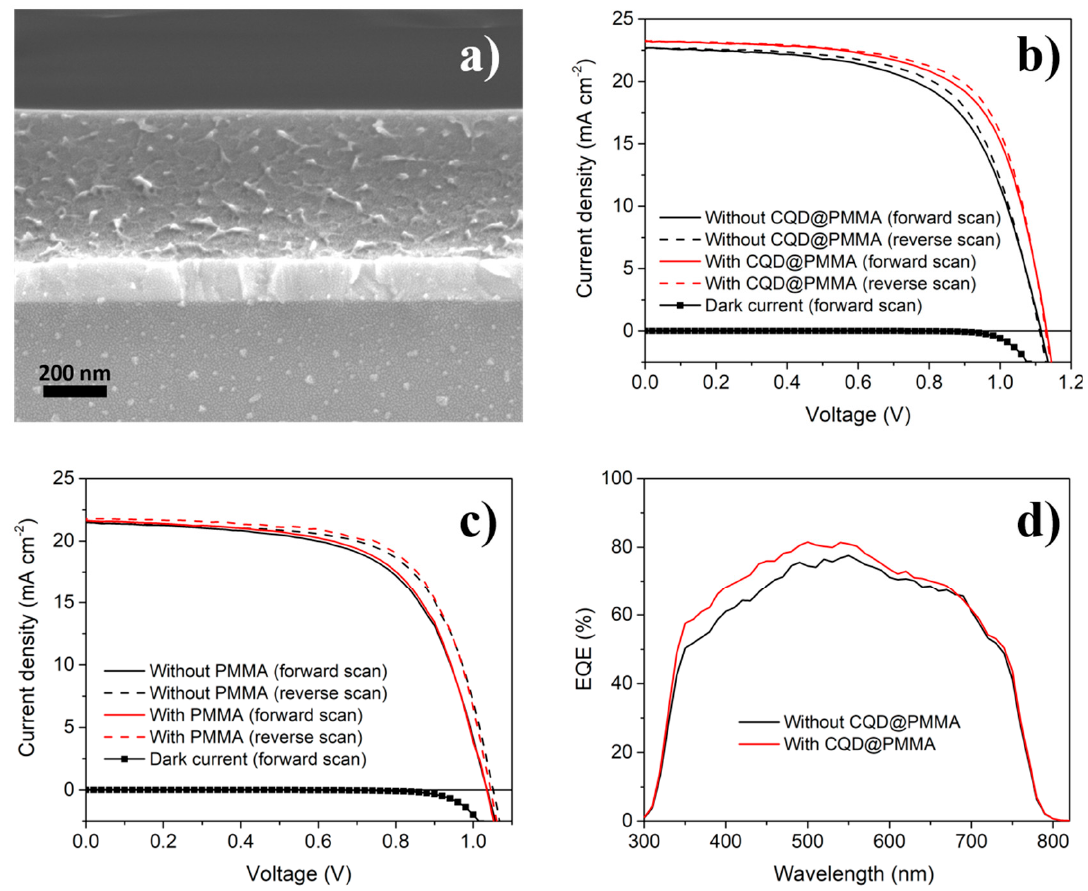
Figure 4. ( a ) Cross-sectional SEM image of a CQD@PMMA coating deposited onto a fluorine-doped tin oxide (FTO) substrate at 3000 rpm. ( b ) J–V characteristics (scan rate 0.5 V s − 1 ) of a PSC device before and after application of a CQD@PMMA coating tested under 1 sun illumination and in the dark (blue solid line). ( c ) J–V curves of a PSC device before and after application of a neat PMMA layer. ( d ) External quantum efficiency (EQE) spectra of a PSC before and after application of a CQD@PMMA layer. Table 1. Photovoltaic parameters for a PSC device before and after application of a CQD@PMMA layer tested under 1 sun illumination.